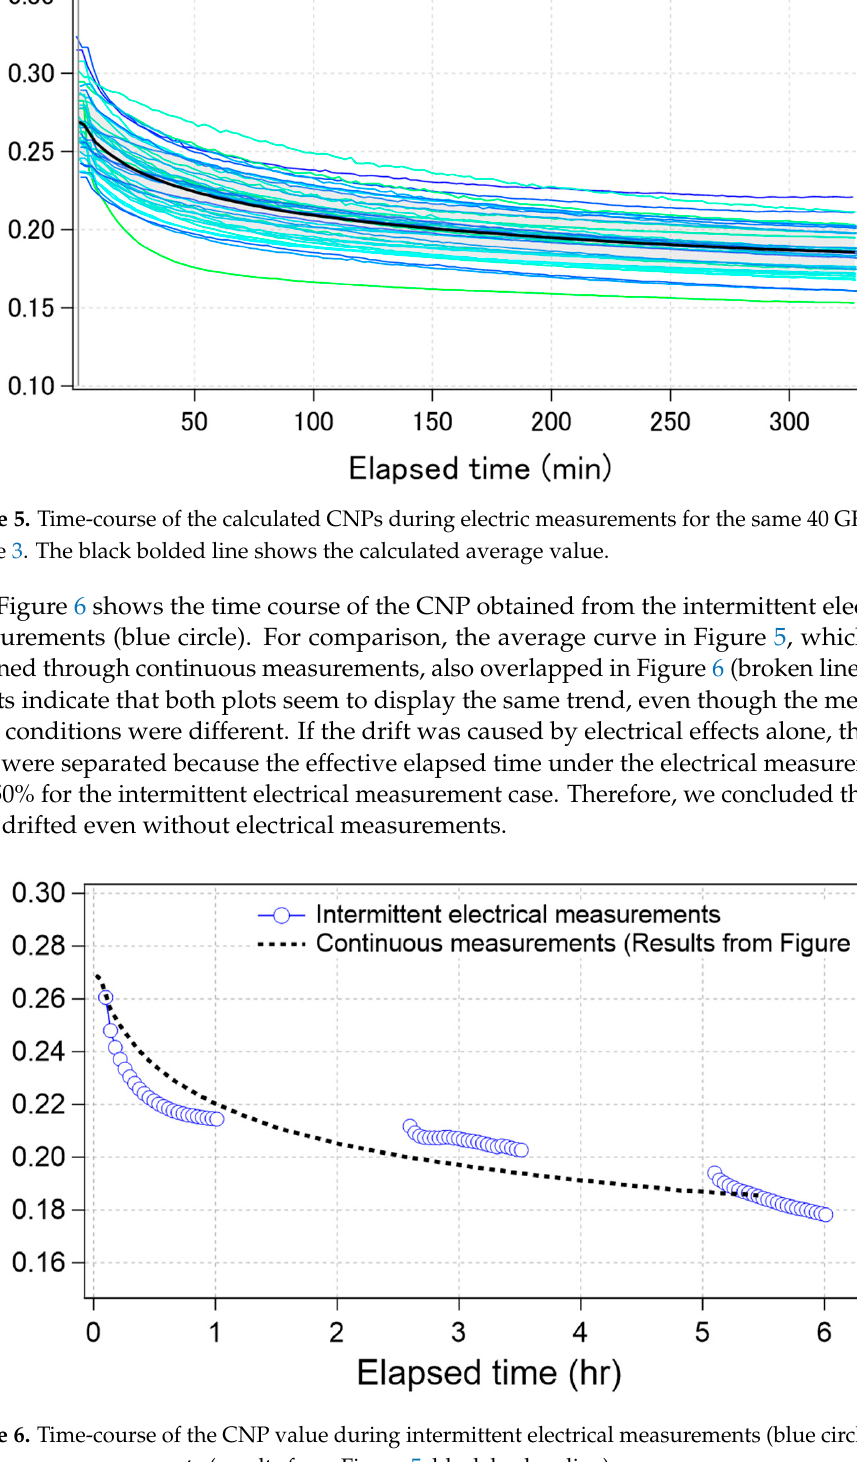
Figure 4. Change of transfer curves from a specific device during measurements. Initial transfer curve (blue circle) and the transfer curve after 10 min measurement (black triangle) and 50 min measurement (red square). Figure 5. Time-course of the calculated CNPs during electric measurements for the same 40 GFETs in Figure 3. The black bolded line shows the calculated average value.